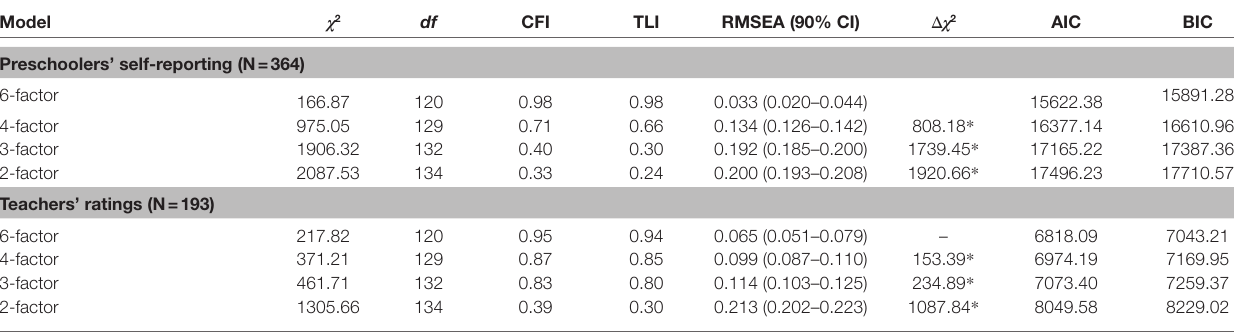
TABLE 1 | Goodness of fit and comparisons of all models.